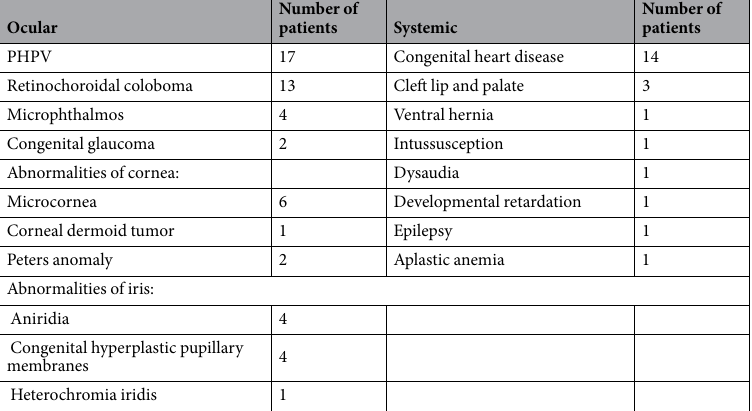
patients: 23.7% (54/228) in unilateral cases and 18.2% (53/292) in bilateral cases (P = 0.12, Chi-square test). Proportion of esotropia: exotropia in unilateral cataract patients were 15:39 and 32:21 in bilateral cases. More exotropia was seen in unilateral cataractous eyes and more esotropia in bilateral cases (exotropia: 72.2% versus 39.6%, esotropia: 60.4% versus 27.8%; P = 0.001, Chi-square test). In bilateral cataract patients with strabismus, axial lengths of esotropia-affected eyes were statistically shorter than exotropia-affected eyes (eyes were randomly selected, 21.05 ± 2.07 mm verse 25.50 ± 3.98 mm, P < 0.001, Student’s t test). Besides, of all the patients, 11.9% (62/520) had nystagmus. Bilateral cataract eyes were accompanied with statistically more nystagmus than unilateral cataract (P < 0.001, Chi-square test). Additionally, there were 5.2% (27/520) of patients who had both strabismus and nystagmus, 20 of which had bilateral cataract. Surgical techniques and visual outcomes.